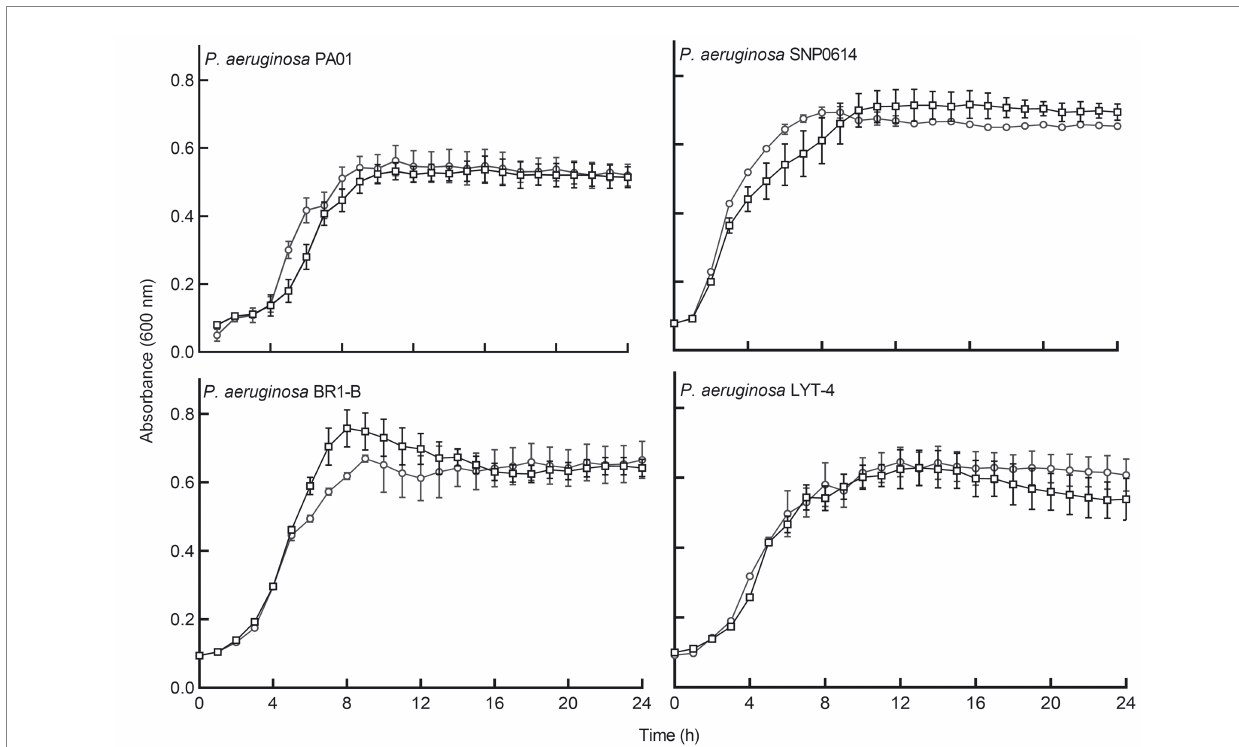
FIGURE 1 E. coli Nissle cell-free supernatant did not significantly inhibit the planktonic growth of four strains of P. aeruginosa . Circular symbols, co-incubation of Pseudomonas aeruginosa strains with Nissle supernatant. Square symbols, control cultures. Data are mean ± SEM, n = 3. Significance was set at p <